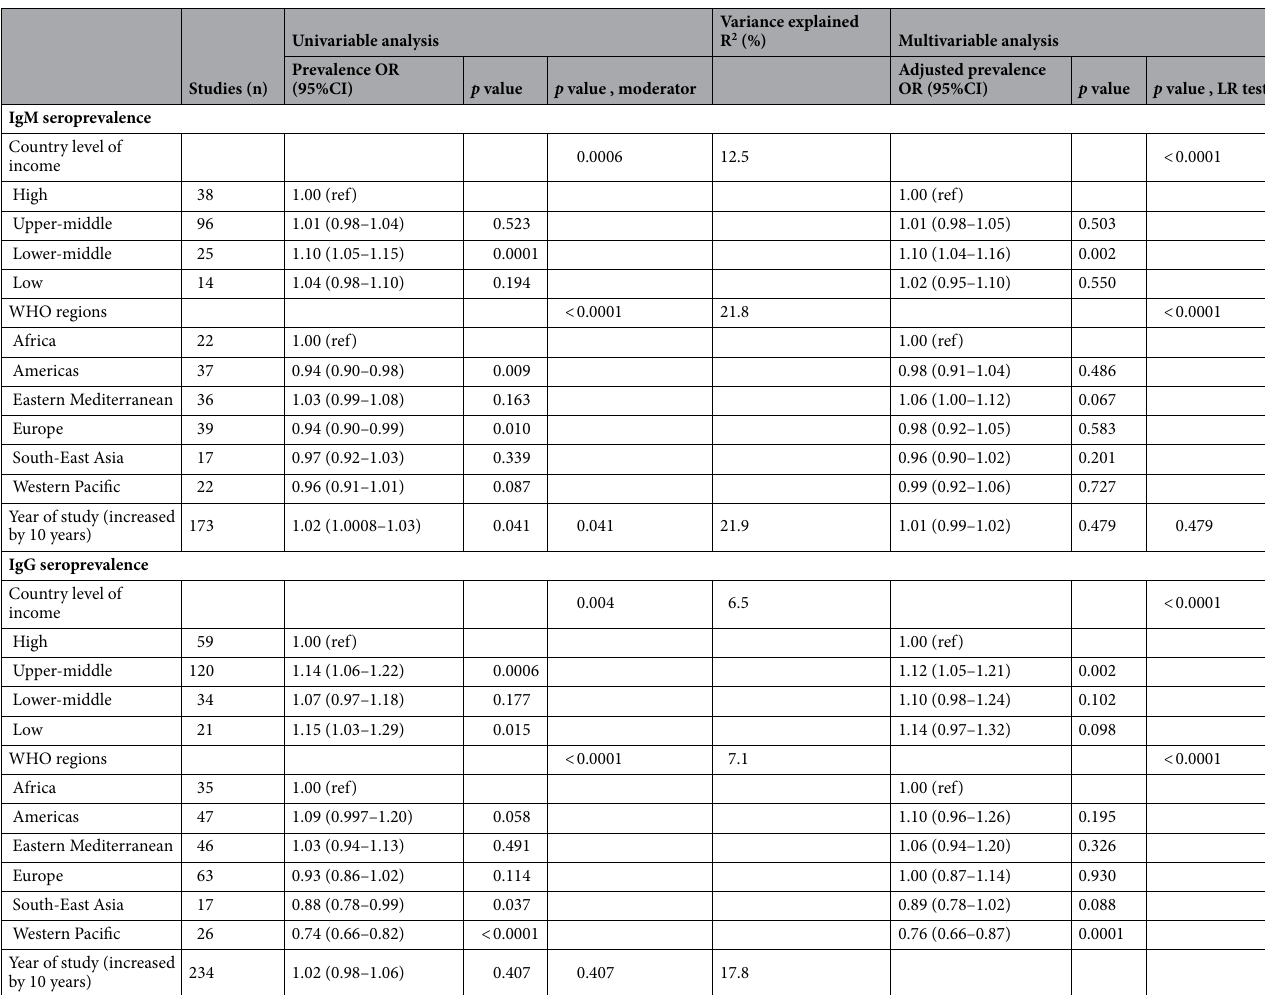
Table 2. Meta-regressions to identify associations and sources of between-study heterogeneity of Toxoplasma gondii seroprevalence in pregnant